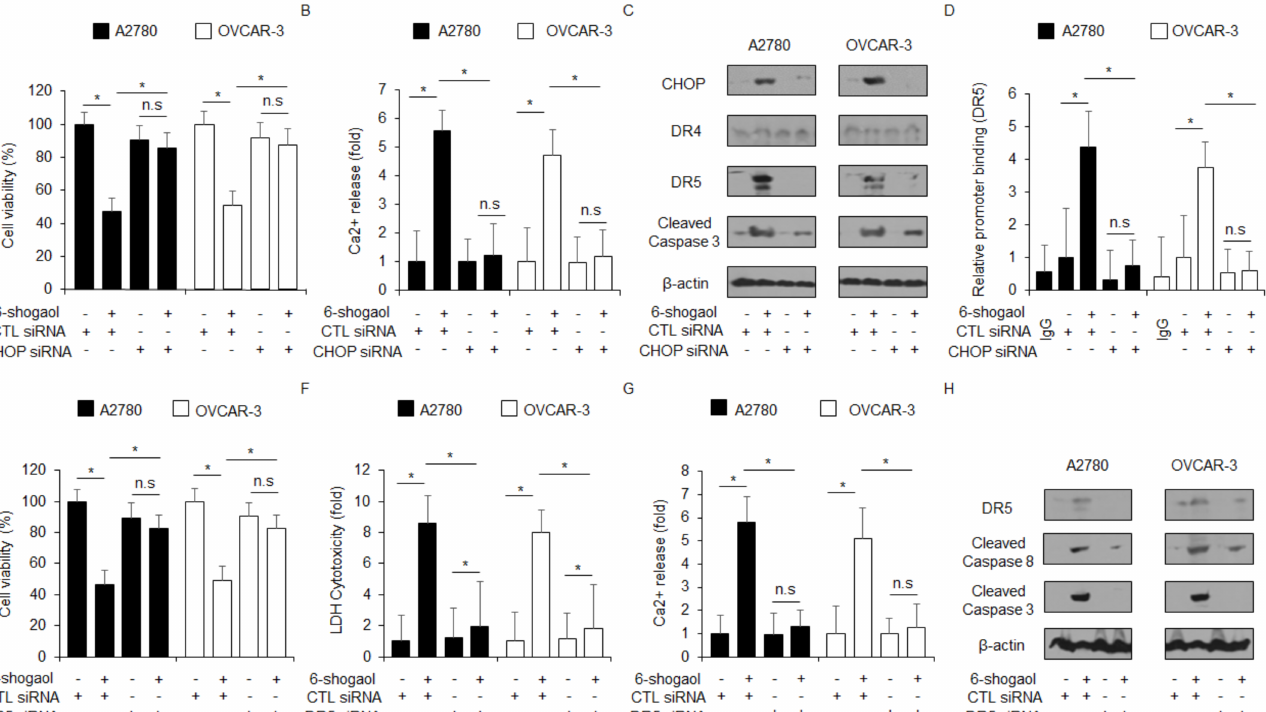
in A2780, A2780R, OVCAR-3, and OVCAR-3R cells when compared with control cells (Figure 8A). 6-shogaol inhibited cell viability and enhanced LDH release in A2780 and OVCAR-3 cells when compared with A2780R and OVCAR-3R cells, and gefitinib/6-shogaol mediated lower cell viability and higher LDH release in A2780 and OVCAR-3 cells when compared with A2780R and OVCAR-3R cells (Figure 8B,C). To determine if gefitinib/6- shogaol inhibits the EMT phenomenon in gefitinib-resistant ovarian cancer cells, we carried out Western blot analyses and real-time RT-PCR. In A2780 and OVCAR-3 cells, 6-shogaol, gefitinib, and gefitinib/6-shogaol showed no change in the expression levels of EMT-related markers, including E-cadherin, N-cadherin, vimentin, Snail, and Slug (Figure 8D,E and Supplementary Figure S1). However, E-cadherin was downregulated, and N-cadherin, vimentin, Snail, and Slug were upregulated in A2780R and OVCAR-3R cells compared to the control (Figure 8D,E). 6-shogaol and gefitinib/6-shogaol induced the upregulation of E-cadherin and the downregulation of N-cadherin, vimentin, Snail, and Slug in A2780R and OVCAR-3R cells compared to the control (Figure 8D,E).